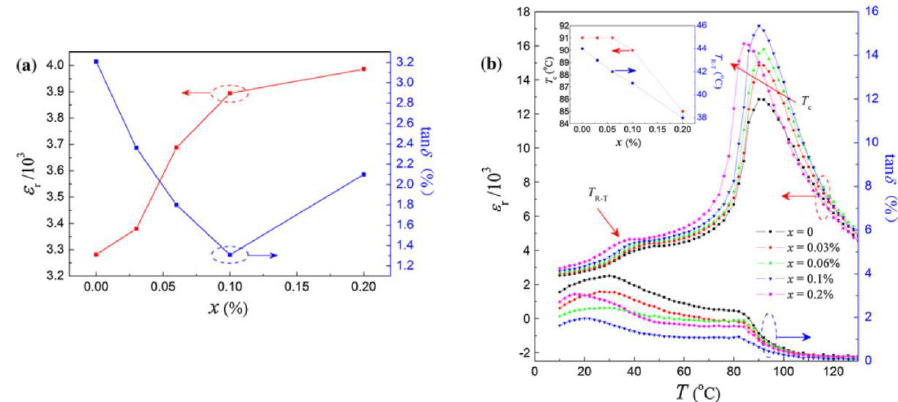
Figure 10. ( a ) Dielectric properties as a function of x at 1 k Hz and ( b ) temperature dependence of the ε r and tan δ of BCZT-xSb ceramics. Reprinted with permission from [78]. Copyright 2011 Springer Nature.